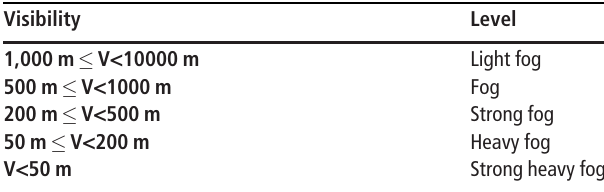
Table 1 Visibility levels in China (GBT 27964 – 2011)